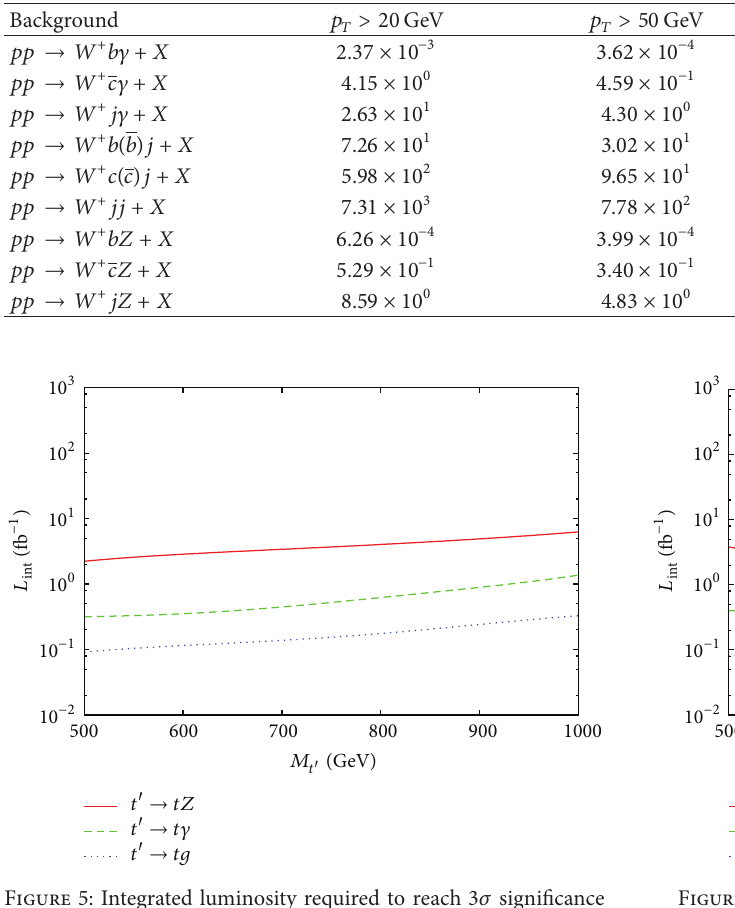
Table 10: The cross sections (in pb) for the relevant backgrounds ( 𝑊 + 𝑏(𝑏)𝑉 , 𝑊 + 𝑐(𝑐)𝑉 , and 𝑊 + 𝑗𝑉 , where 𝑉 = photon, jet, and 𝑍 boson) with √𝑠 = 13 TeV. 𝑝 𝑇 cuts on the jets at the center of mass energy